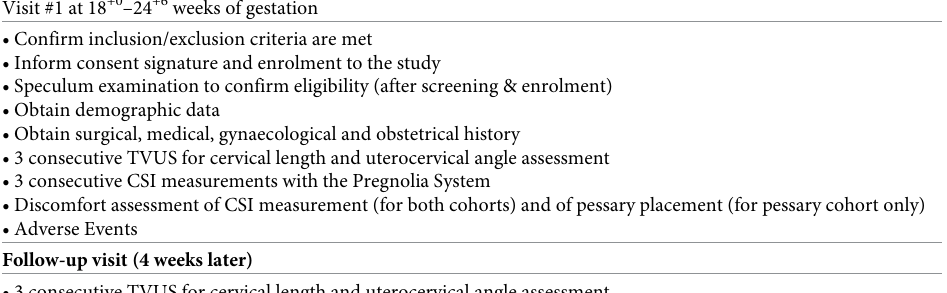
Table 2. Procedures at each